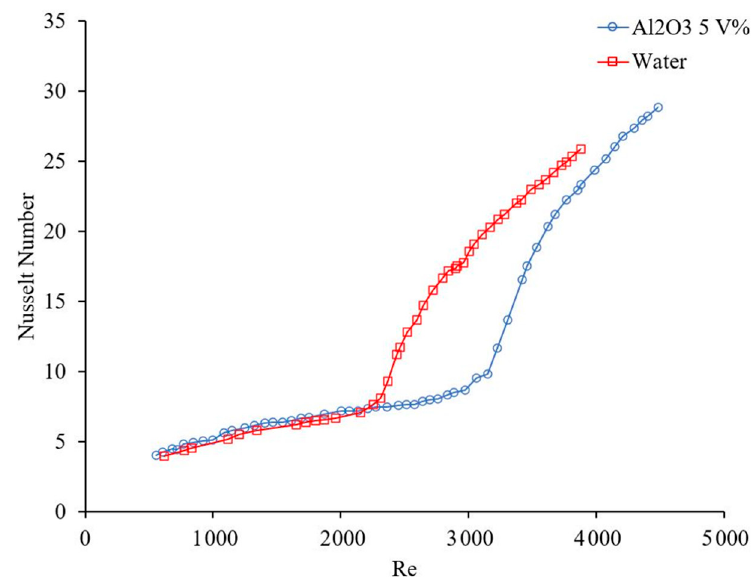
Figure 6. Effect of Reynolds number on heat transfer coefficient, Liu and Yu [17].